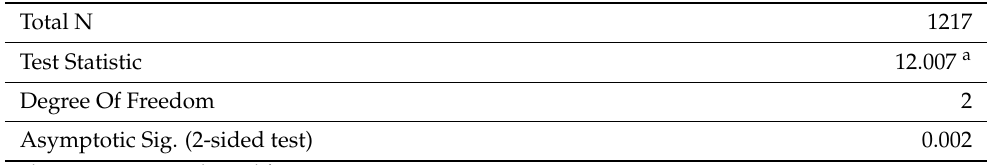
Figure 5. Distribution of viability across different incubation times. The boxplot shows the distribution of viability scores in different incubation durations. Data points that are more than 1.5 box-lengths from the edge of their (blue) box are classified by SPSS Statistics as outliers and illustrated as circular dots. Any data points that are more than three box-lengths away from the edge of their box are classified as extreme points (i.e., extreme outliers) and are illustrated with an asterisk (*). A Kruskal–Wallis H test was run to determine differences in viability scores between the groups that differed in the incubation time (Table 4). Distributions of viability scores were not similar for all groups, as assessed by visual inspection of a boxplot. The distribution of viability scores was significantly different between groups, χ 2 (2) = 12.007, p = 0.002. Table 4. Independent-Samples Kruskal–Wallis H Test Summary. The table shows the independent samples Kruskal–Wallis H test between various incubation time groups’ viability scores. p -value under 0.05 indicate significant differences.